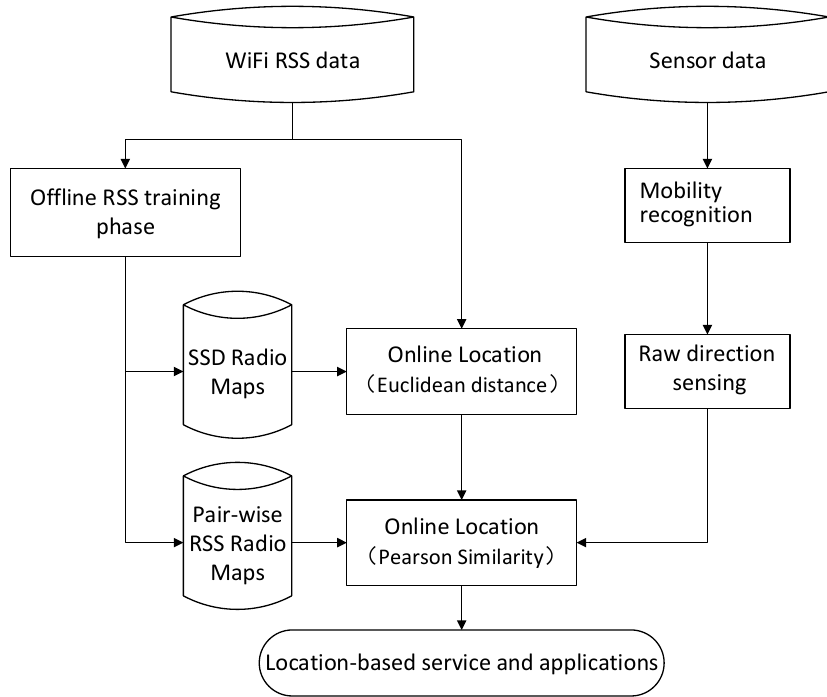
Figure 1. Overall working flowchart for proposed Pairwise Signal Strength Difference (PSSD)